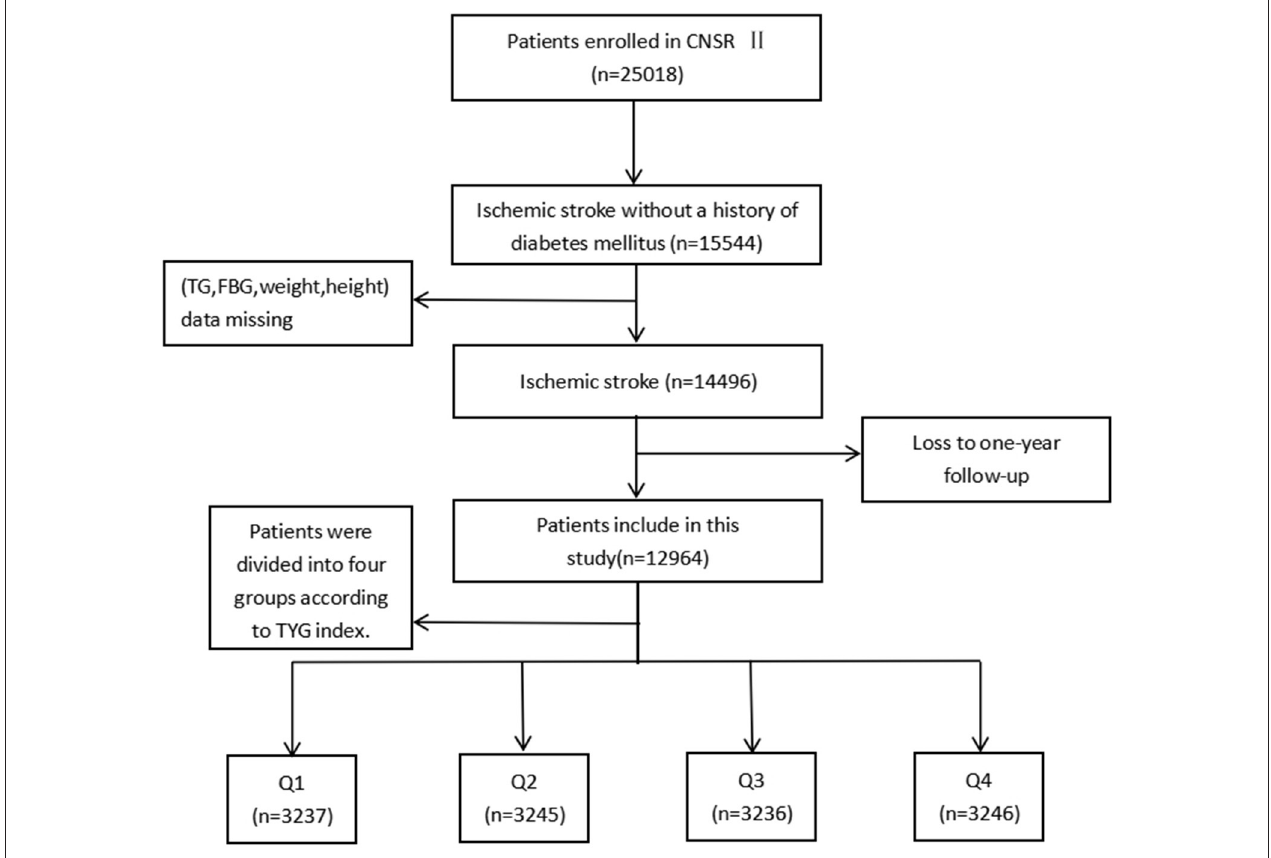
FIGURE 1 | Patients selection flow